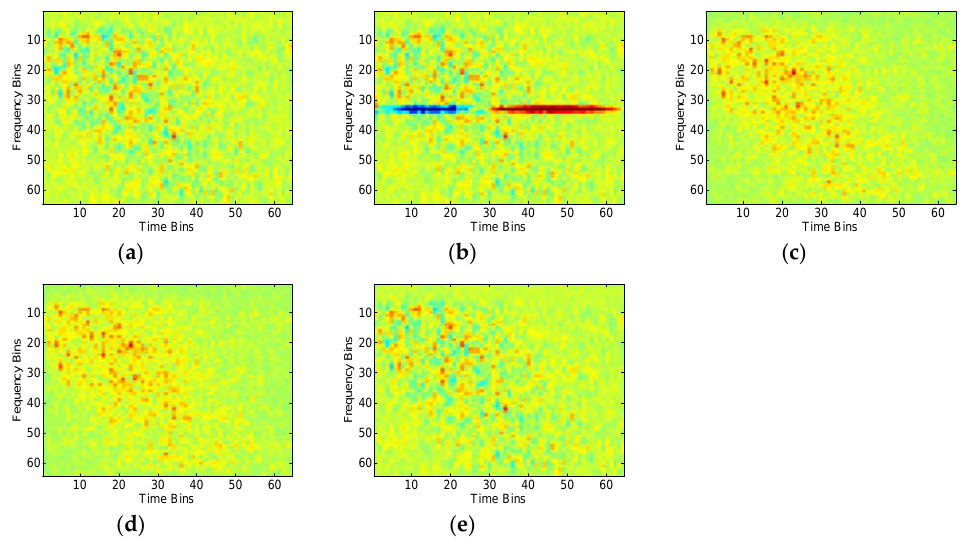
Figure 9. Representation in the time–frequency domain. ( a ) Short-time Fourier transform (STFT) of the NBI-free pulse. ( b ) STFT of the simulated NBI-corrupted pulse. ( c ) STFT after the range spectrum notch filtering. ( d ) STFT after the eigensubspace filtering. ( e ) STFT after the IMN. Table 3. Comparison for the simulated NBI-contaminated echo.